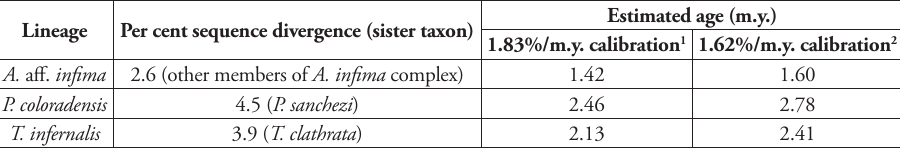
Table 2. COI sequence divergence and estimated ages of Blue Point Spring snail lineages based on two clock